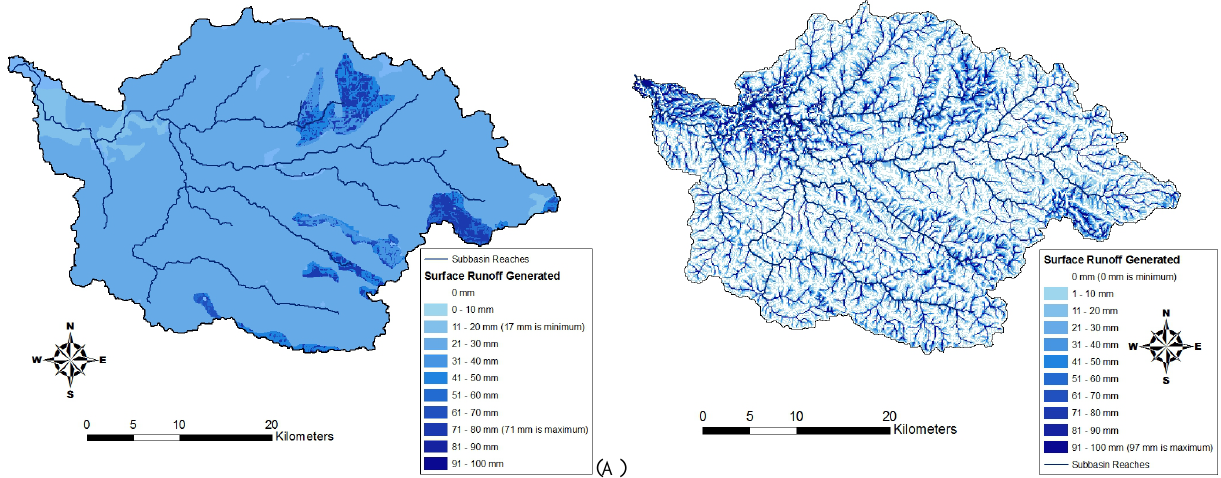
Fig. 1. Spatial distribution of surface runoff in Gumera modelled with (A) SWAT-CN and (B) SWAT-WB (White et al., 2010).